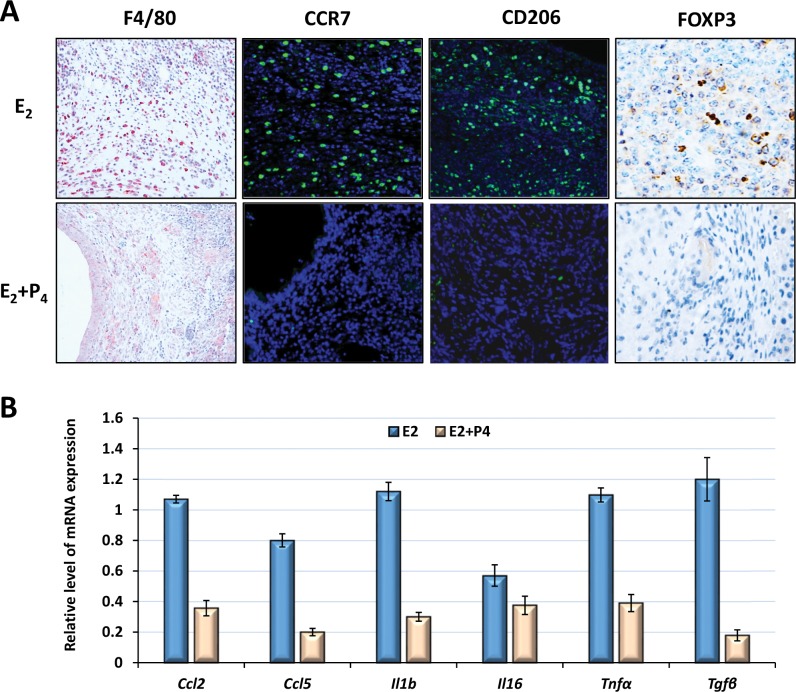
P4 suppresses E2-dependent inflammatory responses in the ectopic lesions.Ectopic lesions were harvested from E2 or E2 plus P4-treated recipients (n = 6) by 16 days after induction. (A) Representative images (20X) showing IHC analysis using antibodies against pan-macrophage biomarker (F4/80), inflammatory M1 (CCR7), anti-inflammatory M2 (CD206) macrophages or Treg cell biomarker (FOXP3), respectively. (B) The relative level of mRNA expression corresponding to Ccl2, Ccl5, Il1b, Il6, Tnfa, and Tgfb was analyzed by qPCR after moralization to the internal control gene, 36B4. The numerical values were analyzed by One-way ANOVA followed by Dunnett’s post hoc test and expressed as mean ± SEM. Statistical significance is defined as #: p < 0.05, *: p<0.01.